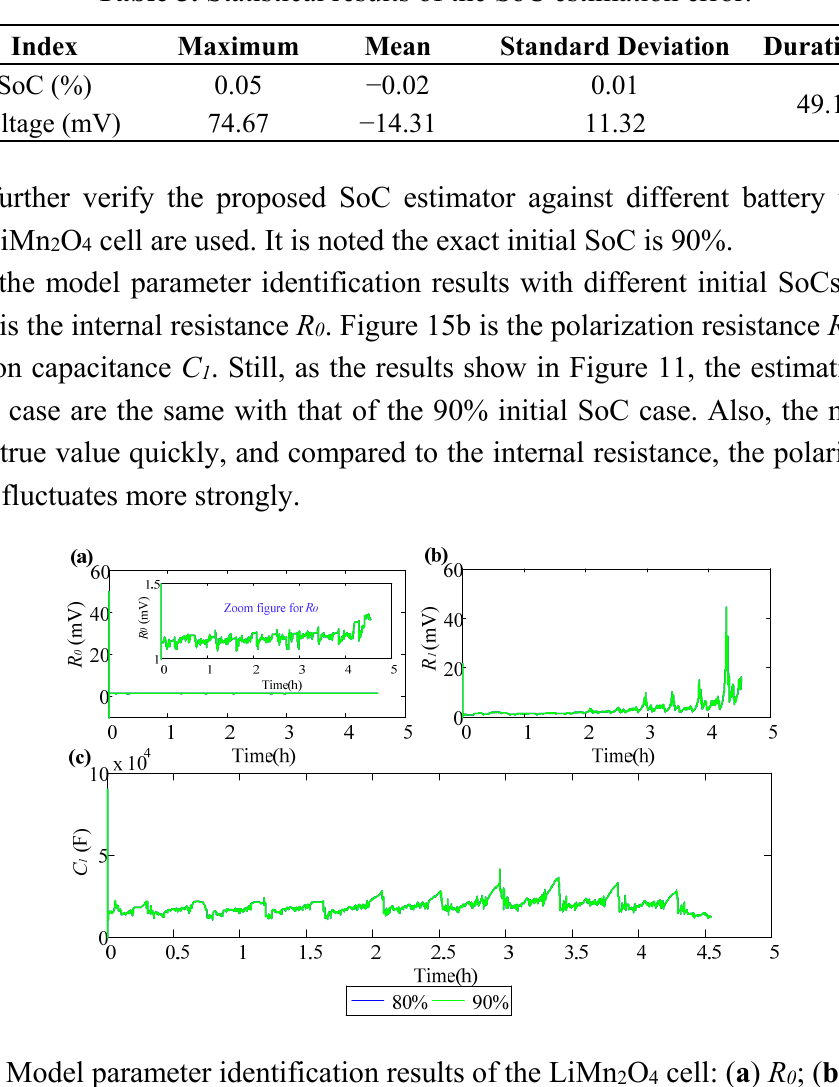
Figure 14. SoC estimation results with an inaccurate initial SoC (SoC 0 = 80%) of the LiFePO 4 cell: ( a ) voltage; ( b ) voltage error; ( c ) SoC; ( d ) SoC error. Table 5. Statistical results of the SoC estimation error.